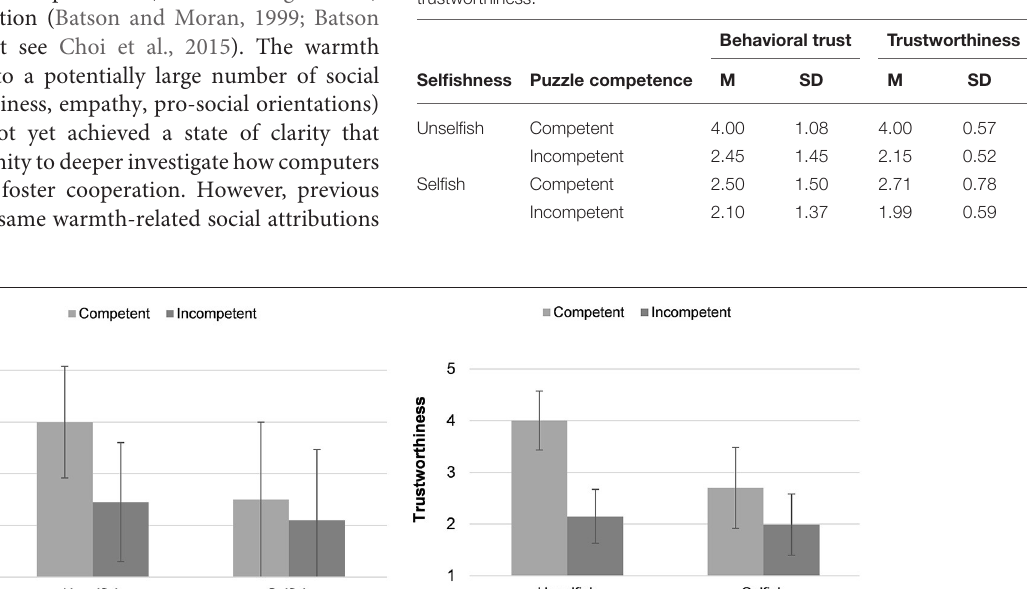
TABLE 4 | Means and standard deviations for behavioral trust and trustworthiness.